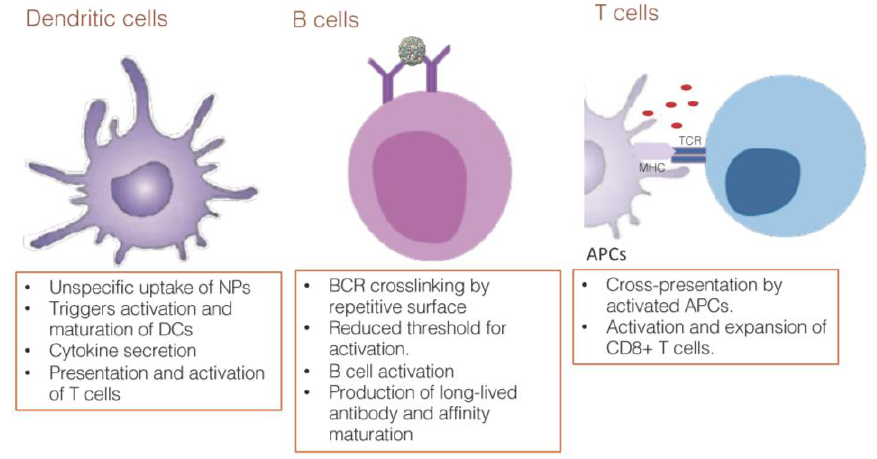
Figure 3. Interaction of NPs and relevant immune cells. APCs such as dendritic cells are the main cells recognizing and driving the immune response against NPs. The unspecific uptake guarantees that those cells will internalize and process most of the pathogens and molecules. The uptake of NPs triggers maturation of DCs and secretion of relevant cytokines that will stimulate other cells, such as T cells, and modulate the immune response. Humoral immune response is favored by the repetitive surface which promotes BCR crosslinking and activation of B cells, leading to activation and production of long-lived antibodies. Cellular and cytotoxic responses are driven by the APCs that internalized the NPs and cross-present the antigens to T cells.